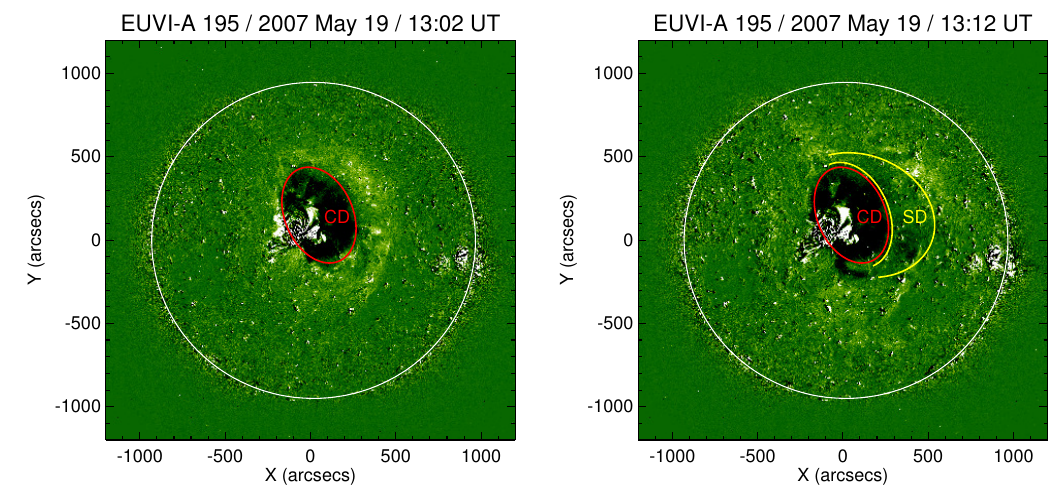
Figure 16: Dimming associated with the coronal wave of 2007 May 19 observed with STEREO/EUVI at 195 ˚A. Shown are base difference images. Note the deep and stationary core dimming ( CD ) and the more shallow secondary dimming ( SD ) that follows the coronal